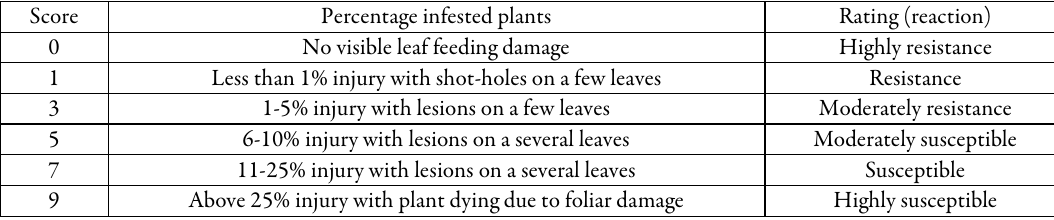
Table 2. Leaf damage rating of pearl millet for resistance to Coniesta ignefusalis